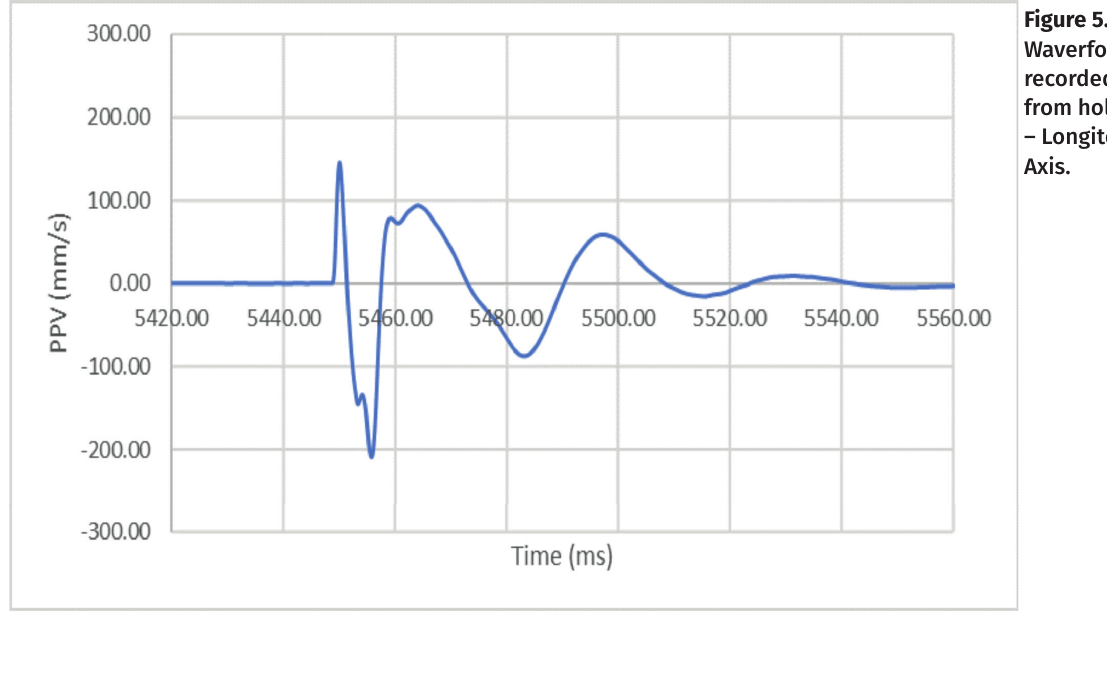
Figure 5. Waverform